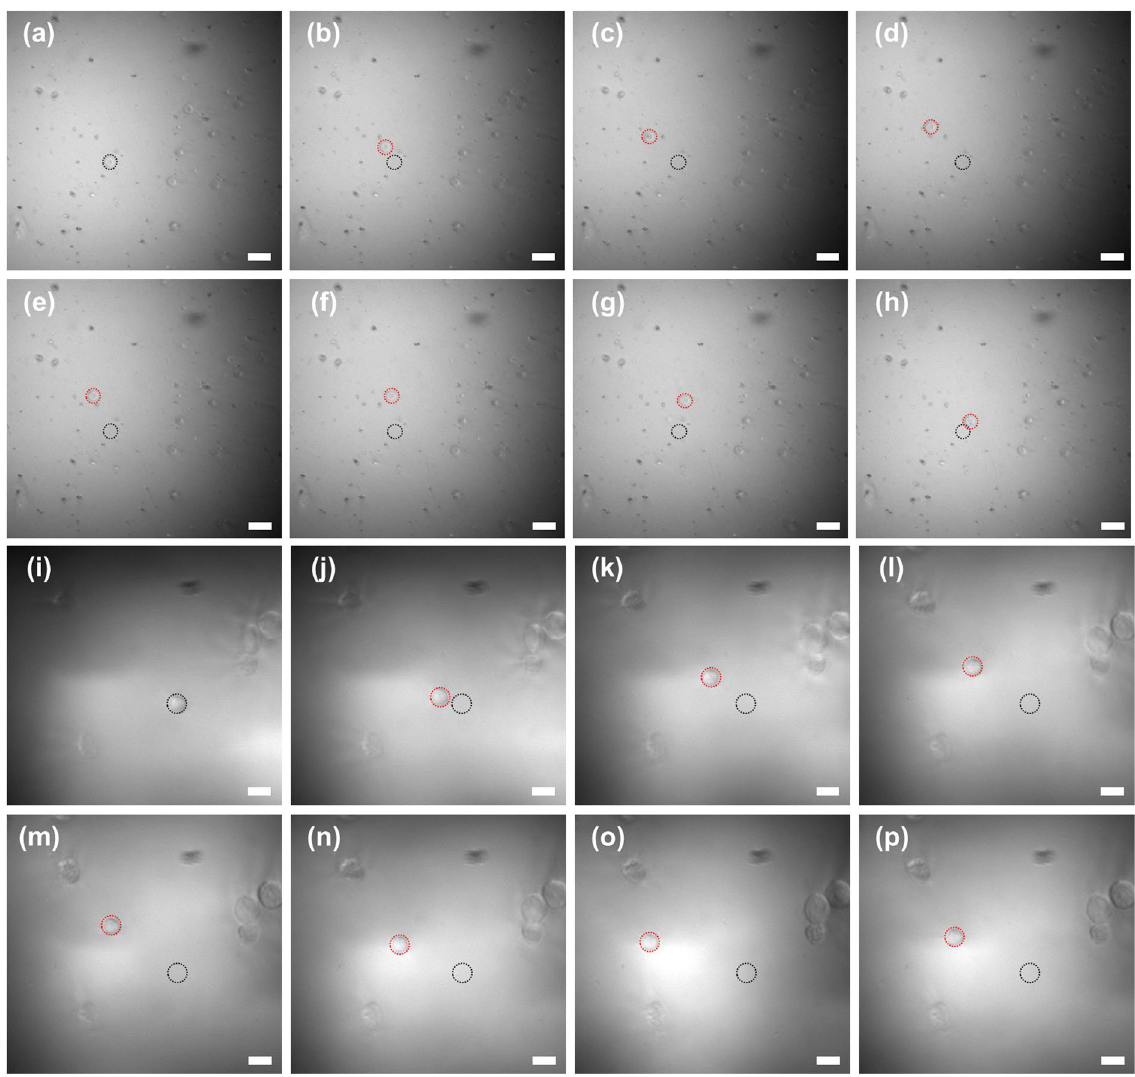
Figure 4. Inverted fluorescence microscope images of RBCs ( a ) to ( h ) and PNT1A cells ( i ) to ( p ) acquired after transmitting monocycle pulses with a length of 6.7 ns and a magnitude of 50 V at a PRF of 167 kHz to tightly focused high-frequency ultrasound transducer. The trapped cells were moved with the movement of the transducer; RBC movement is shown in ( b ) to ( h ) and PNT1A cell movement in ( j ) to ( p ). Black and red dashed circles indicate the initial and moved locations of the transducer, respectively. Scale bars in the images indicate 20 µ